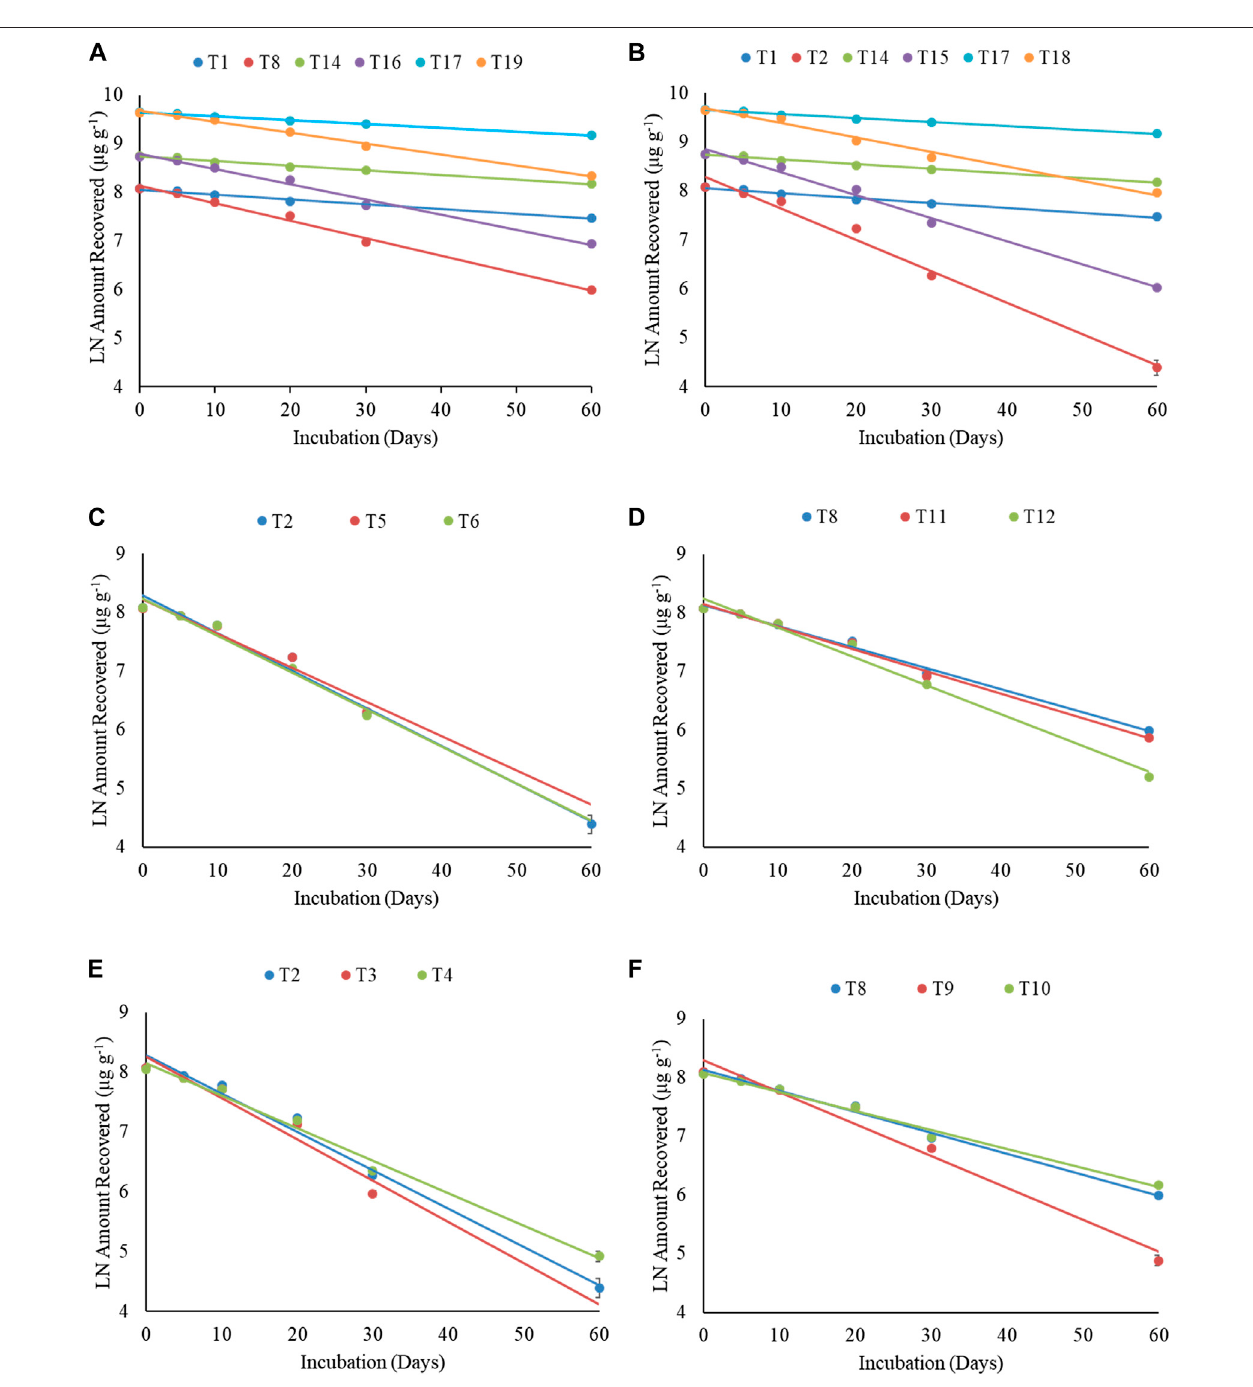
FIGURE3| First-orderdegradationgraphsfortotalpetroleumhydrocarbons. (A) Effectofmicrobialconsortia(freeform)vis-a-viscrudeoilconcentration. (B) Effect offungus(freeform)vis-a-viscrudeoilconcentration. (C) Effectofmicrobialconsortia basedformulationvis-a-vismicrobialconsortia (freeform)and control. (D) Effectof fungalspore – basedformulationvis-a-visfungus(freeform)andcontrol. (E) Effectofnutrientamendmentvis-a-vismicrobialconsortia(freeform)andcontrol. (F) Effectof nutrient amendment vis-a-vis fungus (free form) and control in sandy loam soil.